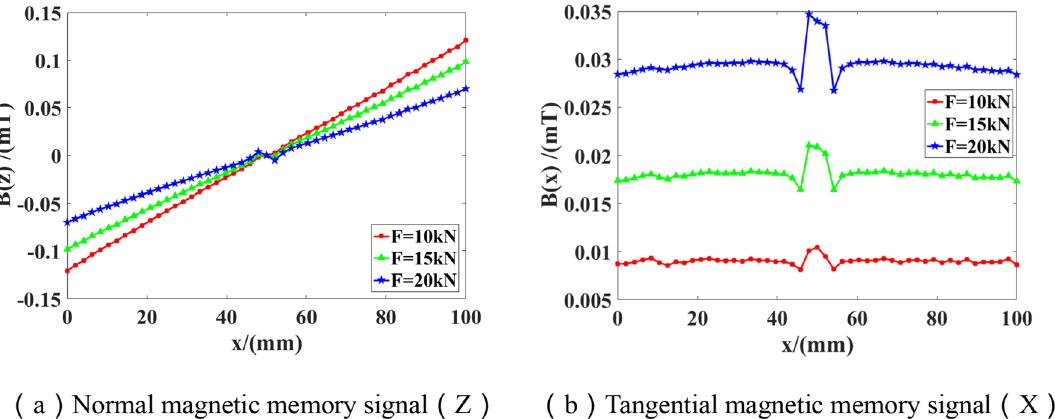
Fig. 9 Magnetic memory signal changes in geomagnetic environment under different tensile forces of transverse cracks. a Normal magnetic memory signal (Z). b Tangential magnetic memory signal